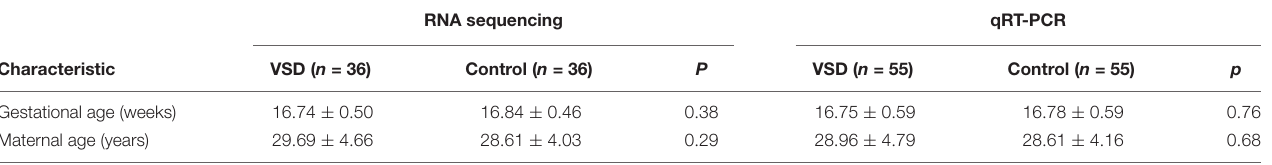
TABLE 1 | Clinical characteristics of pregnant women carrying fetuses with VSD and normal (control) fetuses in RNA sequencing and qRT-PCR analyses. RNA